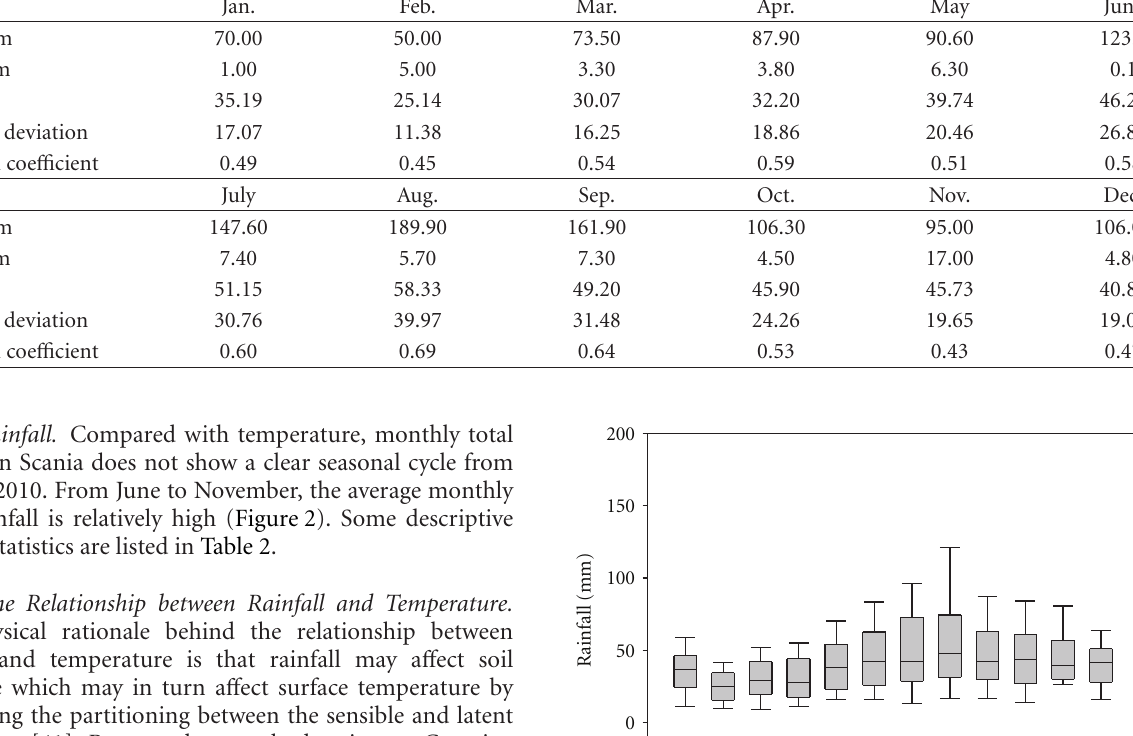
Table 2: Descriptive statistics for monthly total rainfall from 1961 to 2010 (unit: mm). Jan. Feb. Mar. Apr.